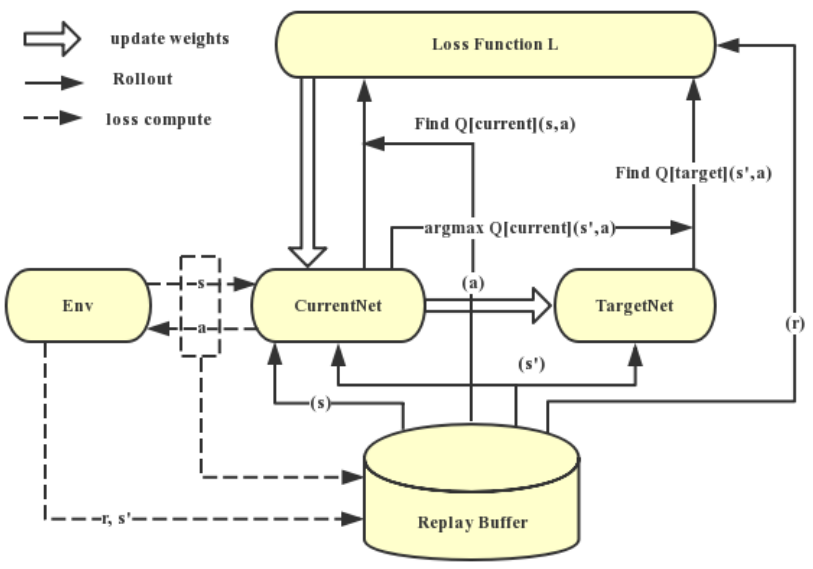
Figure 2. DDQN technical principle framework.